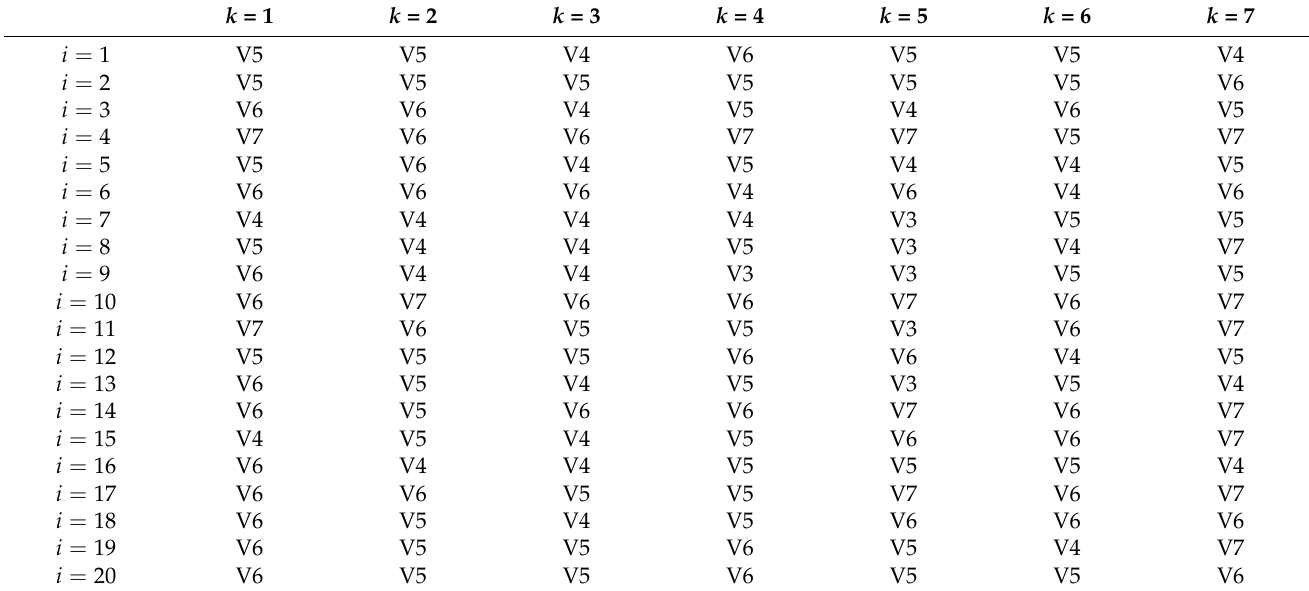
Table 4. The fuzzy decision matrix.